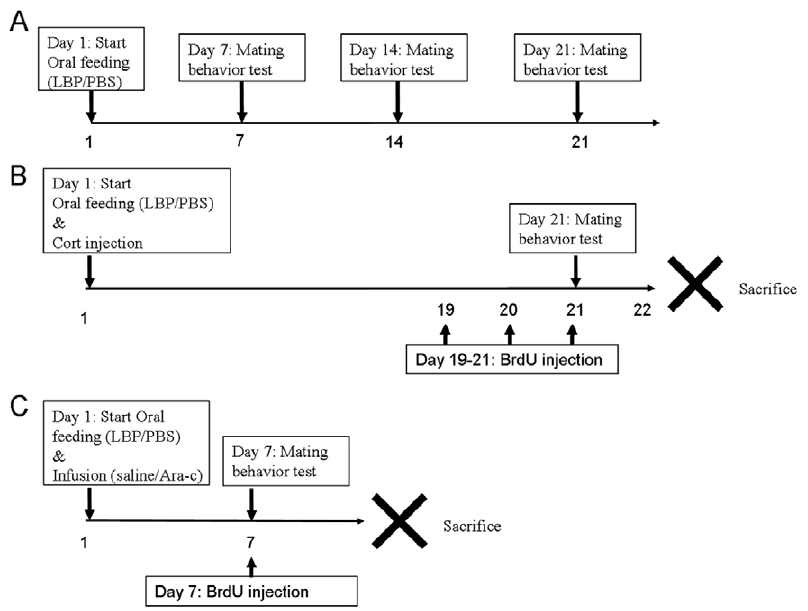
Figure 1. Treatment schedule of experiment 1 (A) and experiment 2 (B). (A): Animals were treated with 0, 1 or 10 mg/kg of LBP daily and sexual behavior tests were conducted at 7-day intervals. (B): The three groups of animals received vehicle (PBS), corticosterone (40 mg/kg) or both corticosterone and LBP treatment for 21 days. Sexual behavior test was conducted at day 21 and was followed by sacrifice of animals at day 22. (C): After intracerebroventricular infusion of either saline (with PBS treatment) or Ara-c (with LBP treatment) for seven days, the animals were subjected to sexual behavior test.